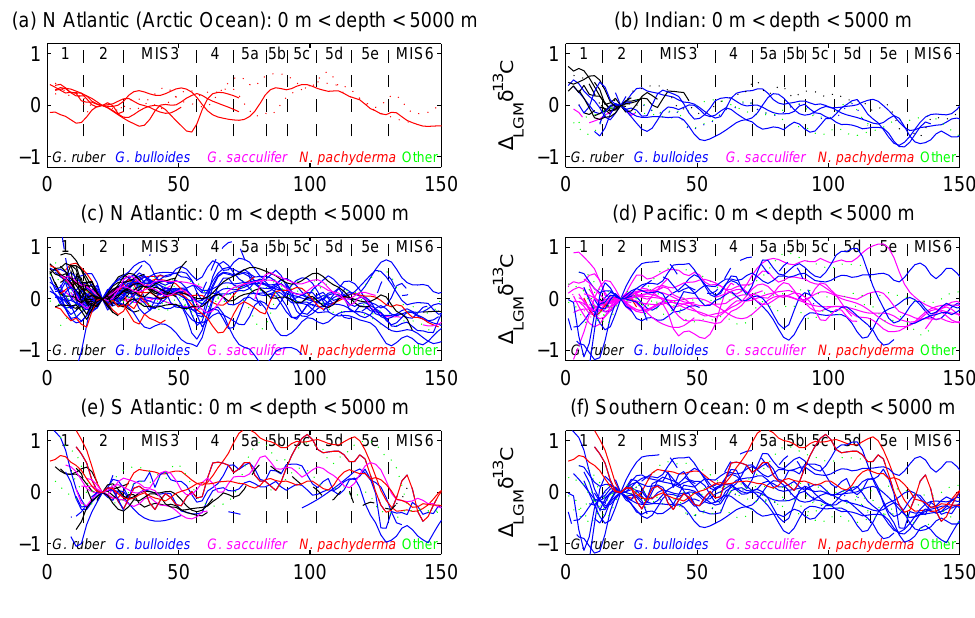
Fig. 8. Planktonic 1 LGM δ 13 C time-series by region. Error estimates are < 0.5‰ (solid), < 0.6‰ (dashed), < 0.8‰ (dotted); data with larger error estimates are not plotted (note these thresholds are different from thresholds for benthic data). Colours indicate planktonic species: G. ruber (black); G. bulloides (blue); G. sacculifer (magenta); N. pachyderma (red); other (green).